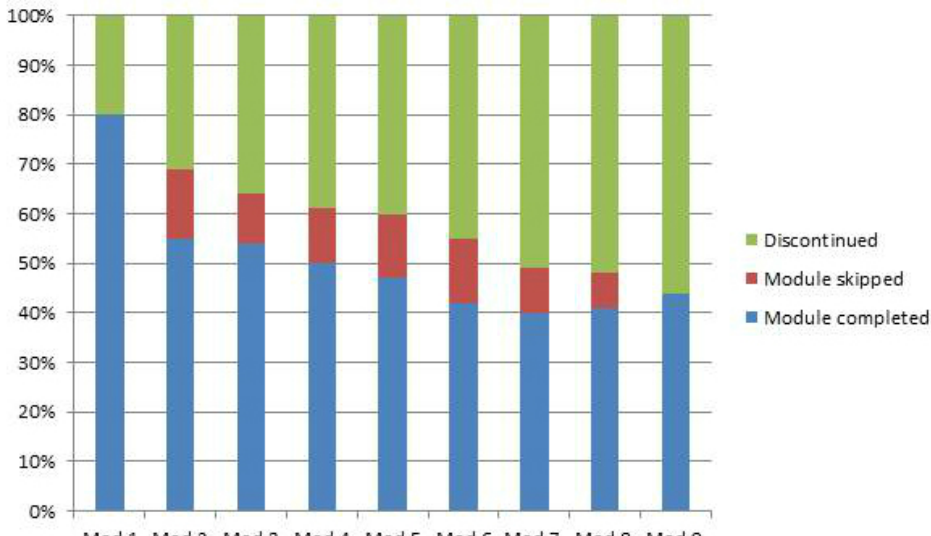
Figure 2. Program